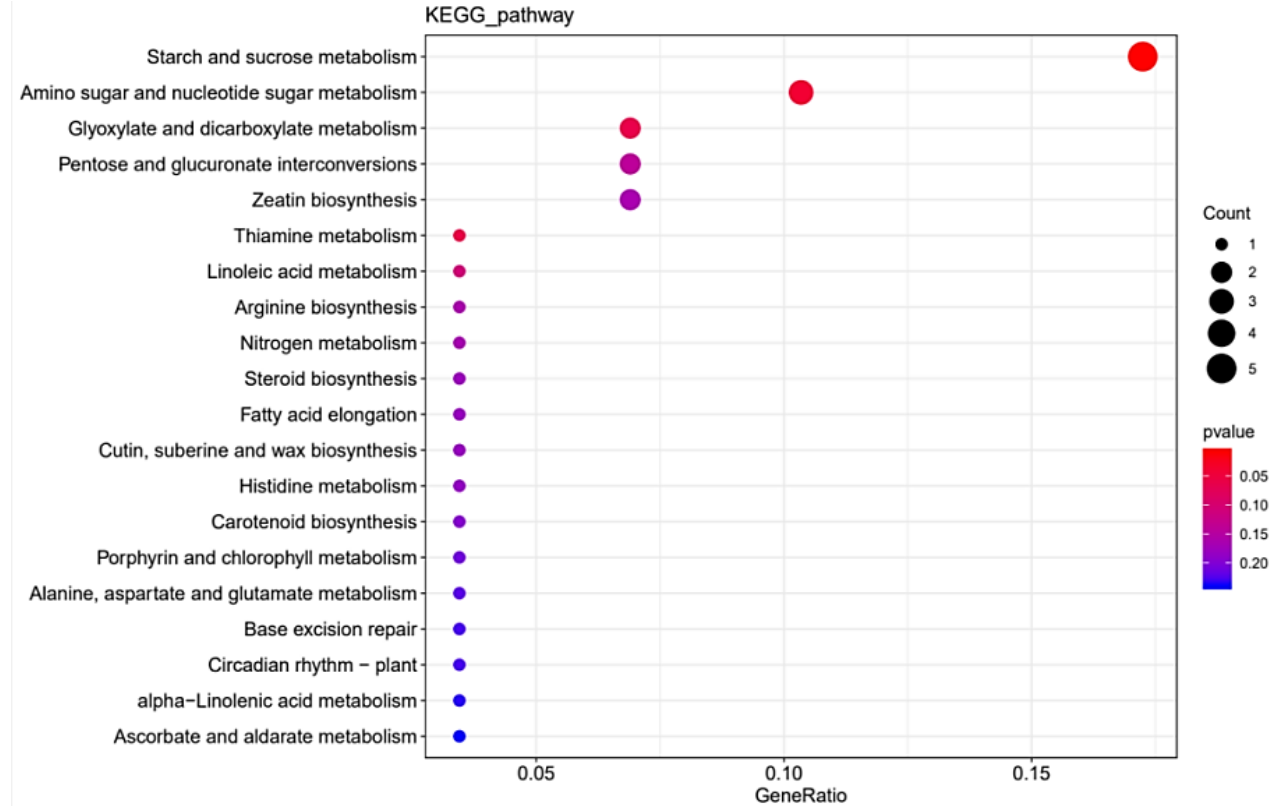
Figure 9. The enriched KEGG pathway of differentially expressed genes.